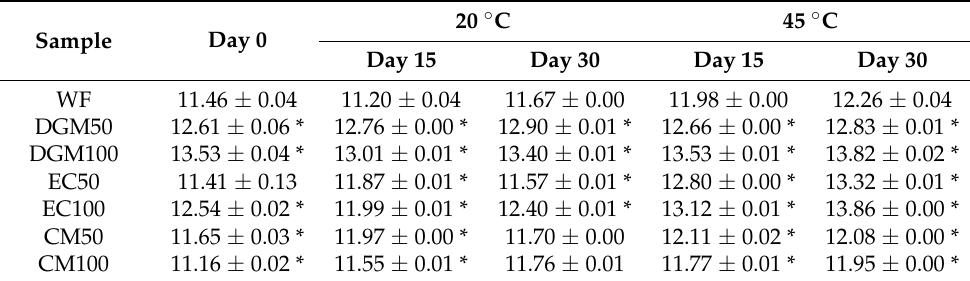
Table 8. Effect of addition of non-encapsulated (DGM), encapsulated (EC) and color-masked